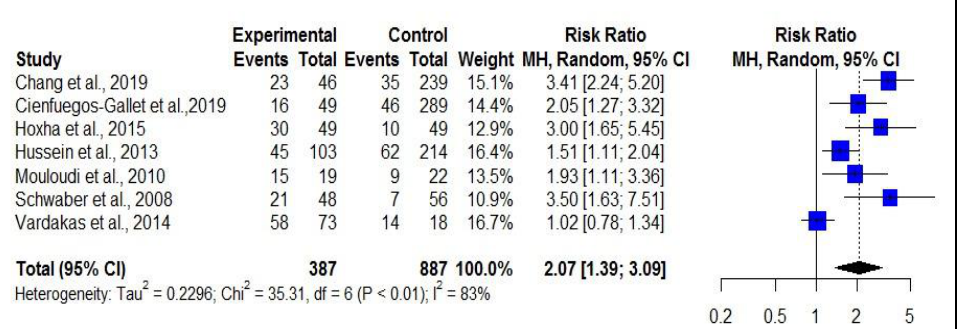
Figure 3. Risk of death of patients with CRKP when compared to patients with CSKP.